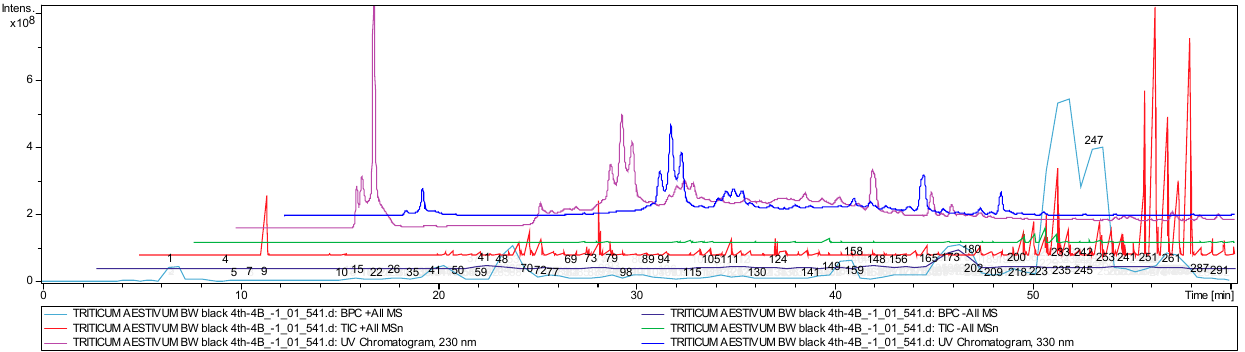
Figure 2. Chemical profiles of the BW BLACK (4Th-4D) sample presented as a total ion chromatogram from the EtOH extract.